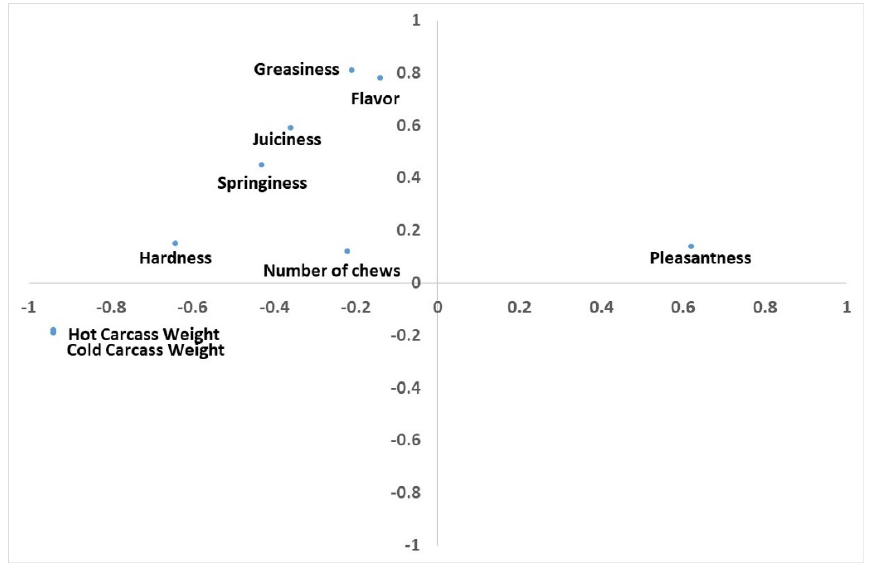
Figure 2. Projection of the sensory and zootechnical quality measurements in the plane defined by the first two principal